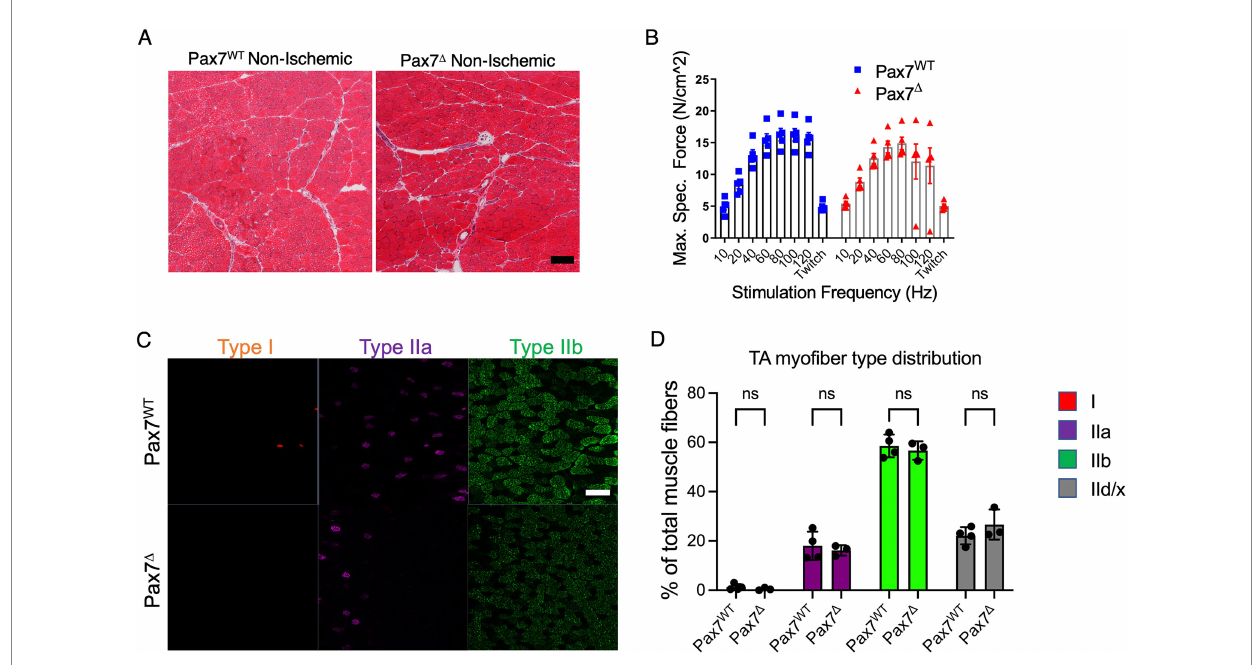
FIGURE 1 Pax7 + MPC ablation does not alter resting muscle morphology 1 week after ischemia. (A) H&E stains of skeletal muscle from mice with ablated satellite cells are not distinguishable from those with intact satellite cells ( n = 3–4 per group). (B) EDL muscles from mice ( n = 5 per group) were isolated, and their ability to generate force was measured on a force transducer. Ablation of satellite cells did not impair the ability of resting skeletal muscle to generate force. Data shown are means +/ − SEM. (C) Representative immunostains of type I, IIa, and IIb myofibers in non-ischemic limbs of Pax7 WT and Pax7 Δ mice. (D) Quantification of relative percentages of each myofiber type in non-ischemic muscle of Pax7 WT and Pax7 Δ mice. Pax7 + MPC ablation did not alter non-ischemic resting muscle fiber type distribution 1 week after ischemia ( n = 3–4 per group). Type IId/x myofibers were quantified by lack of staining for the other three markers. All data shown are means +/ − SEM; p = ns for all comparisons. Scale bar = 100 μ